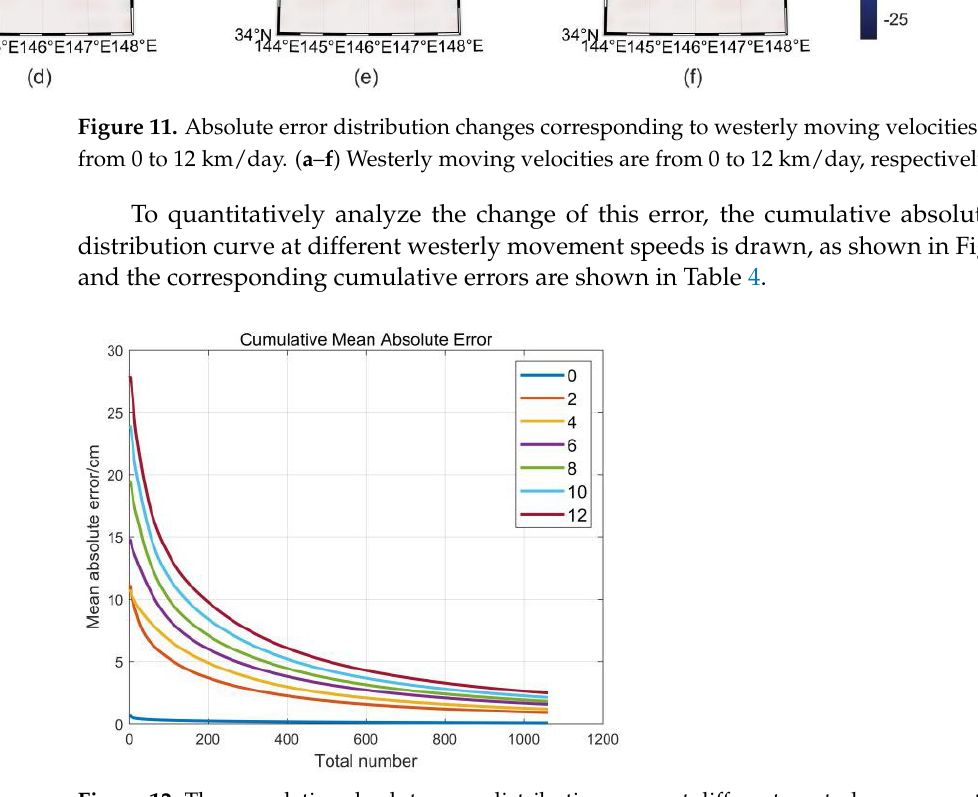
Figure 12. The cumulative absolute error distribution curve at different westerly movement speeds. Table 4. The value of the cumulative absolute error at different westerly movement speeds.